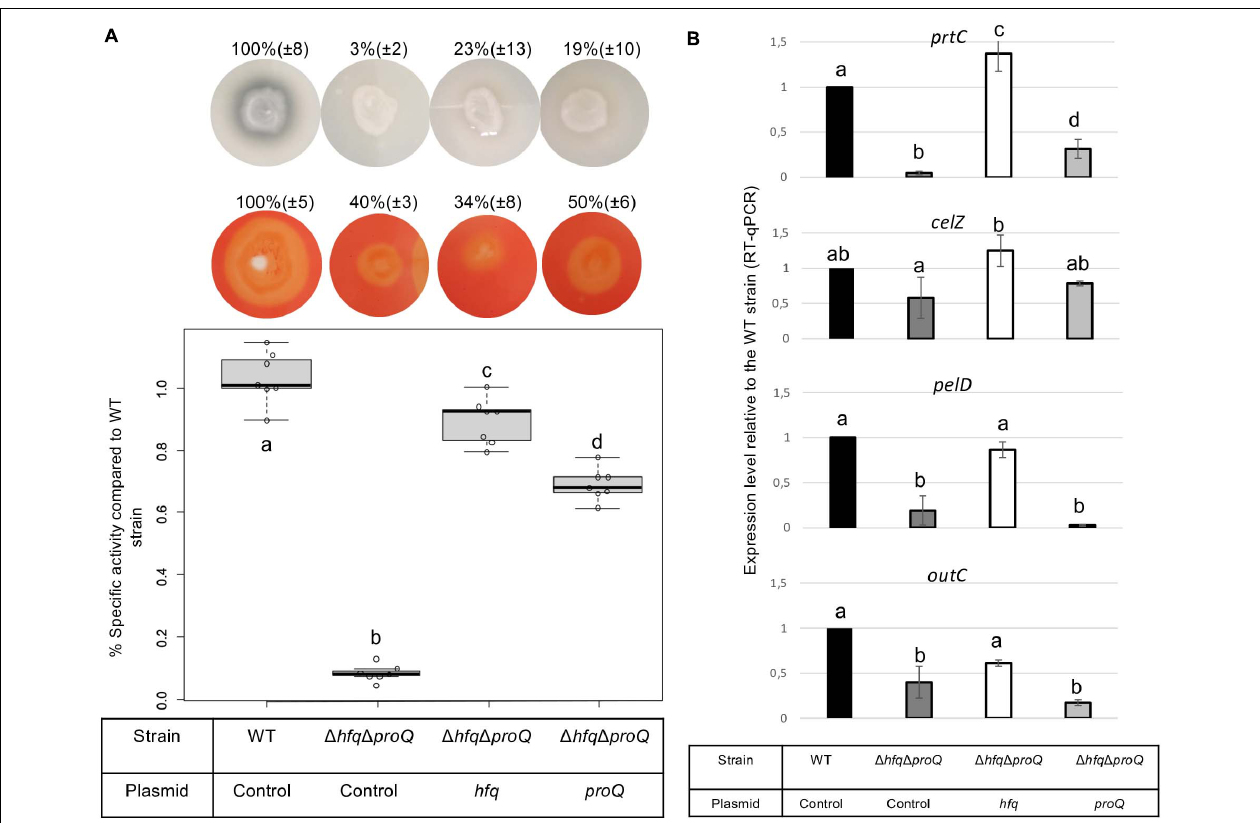
FIGURE 7 | Impact of the double mutant on late virulence factors. (A) Protease production on medium containing skim milk, cellulase production on carboxymethylcellulose agar plates with Congo red staining, and pectate lyase activity expressed as percent of wild type strain specific activity were evaluated in the double mutant and in the double mutant complemented by Hfq or ProQ. Experiments were repeated at least three times. Non-capital letters a, b, c, and d are presented above the boxplots and histograms. Groups with the same letter are not detectably different (are in the same set) and groups that are detectably different get different letters (different sets). Groups can have more than one letter to reflect “overlap” between the sets of groups. Note that if the groups have the same letter, this does not mean they are the same, just that there is no evidence of a difference for that pair ( P < 0.05, Wilcoxon Mann-Whitney test). (B) expression levels of prtC, celZ, pelD , and outC measured by RT-qPCR in the double mutant and double mutant complemented by Hfq or ProQ. Expression levels were compared with those measured in the WT